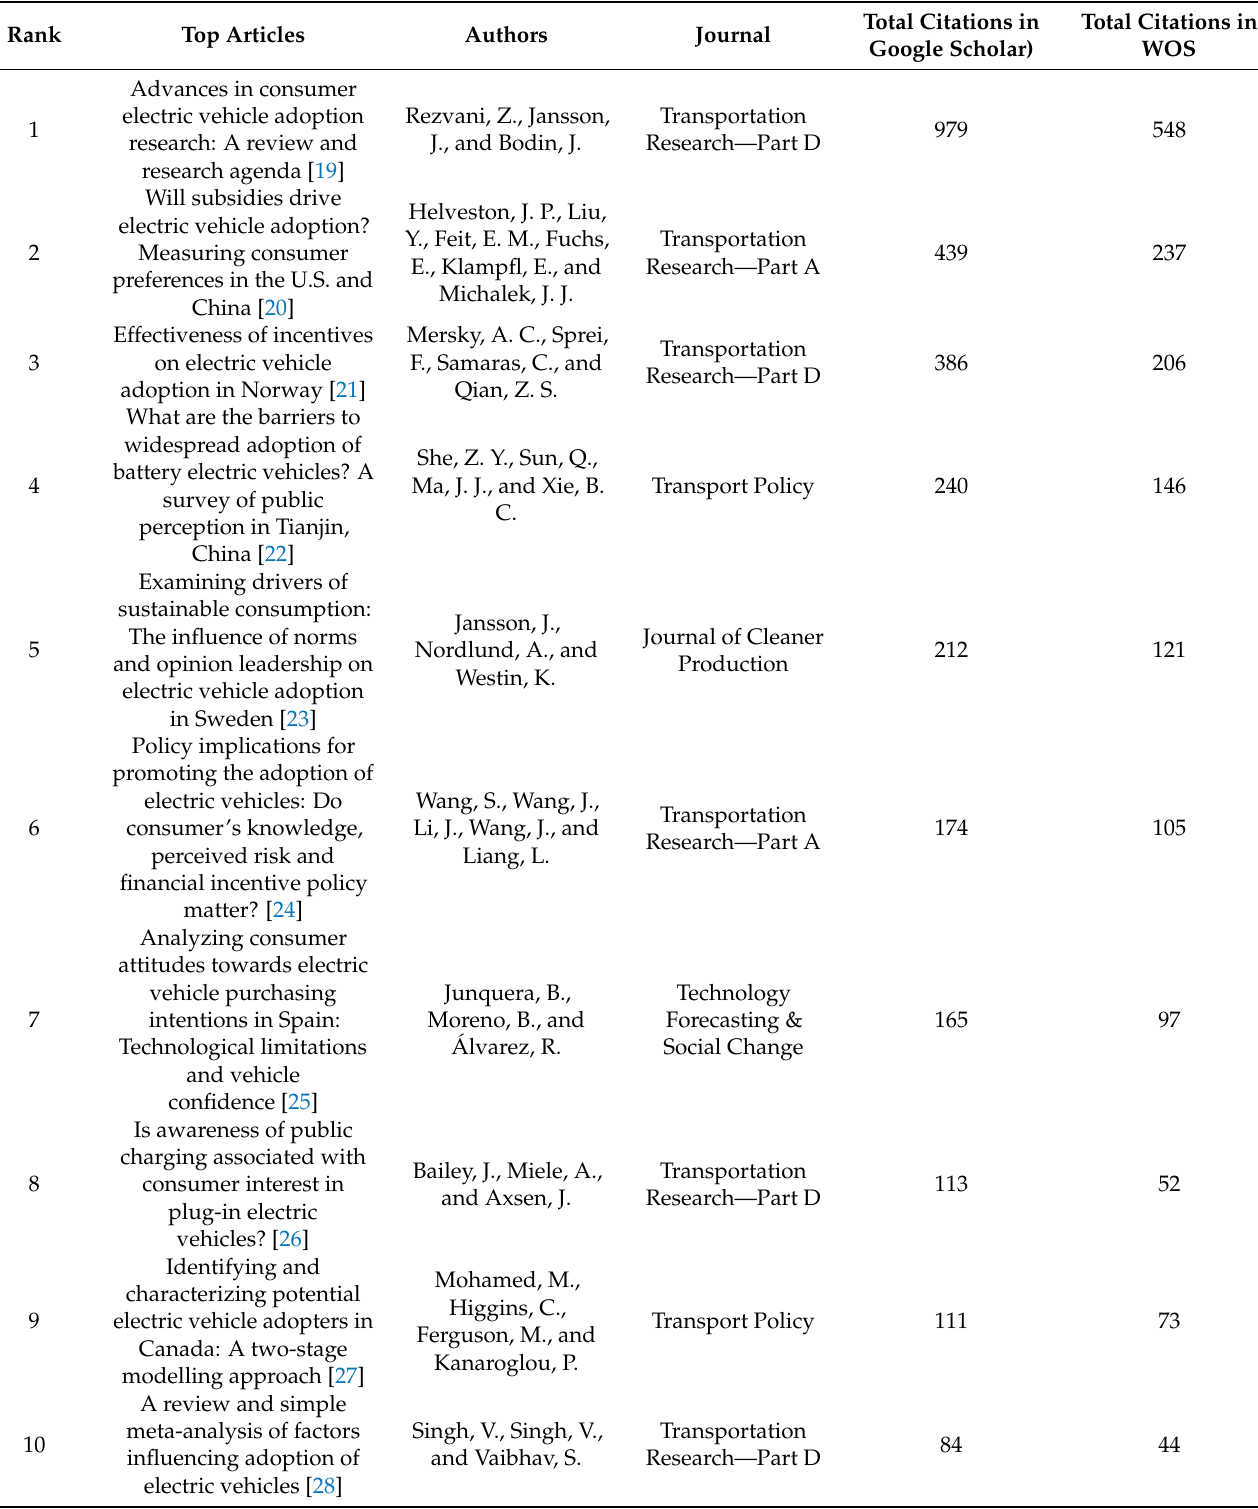
Table 2. Most influential